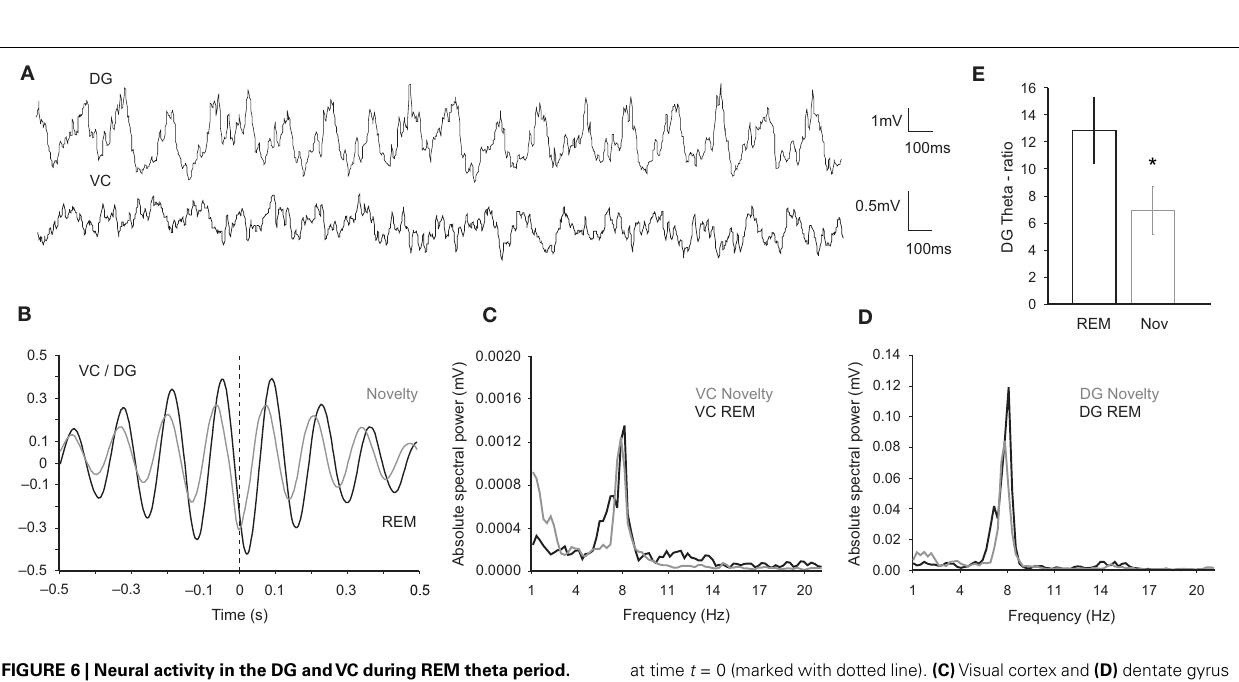
FIGURE 6 | Neural activity in the DG and VC during REM theta period. (A) Original traces of fi eld potential recordings in the DG (upper trace) and the VC (bottom trace) during REM theta period (non-aroused theta, see Materials and Methods). (B) Cross-correlation analyses of activities in the DG and the VC during the REM theta periods (black trace, n = 4) reveal higher peak-to-trough correlation coeffi cient in comparison to the novelty group (grey trace, n = 4), but lower mean correlation coeffi cient calculated